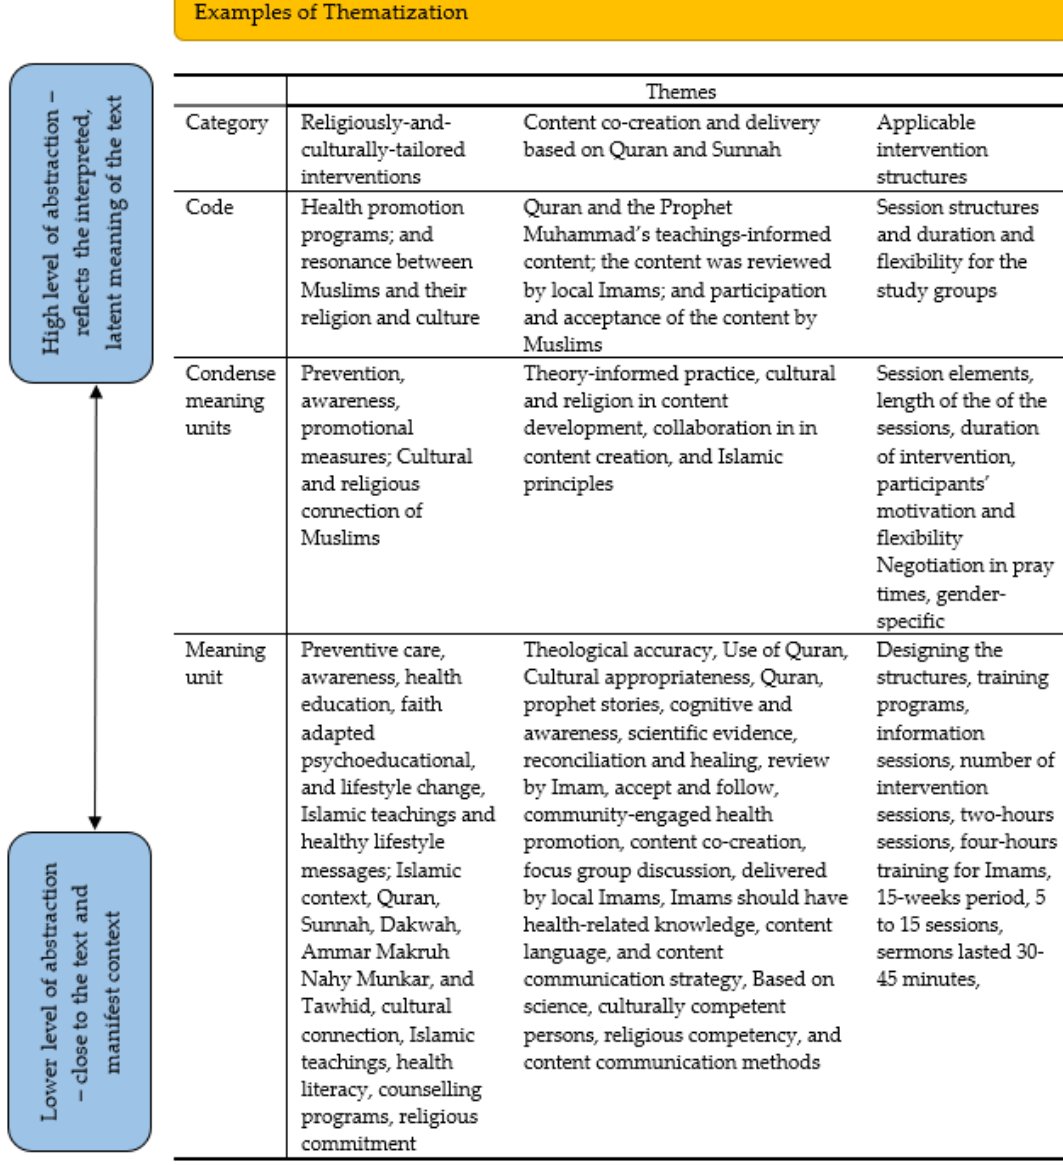
Figure 2. Steps of analysis.